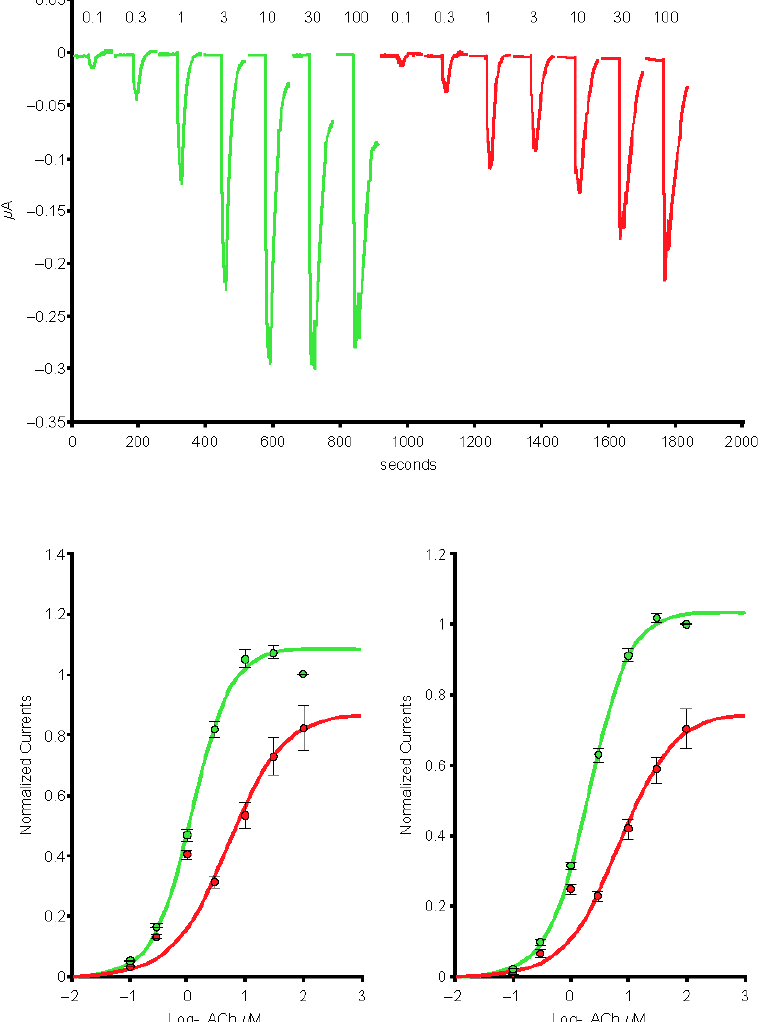
Figure 5. Effects of SARS-CoV-2 Spike protein S1 subunit at the human α 4 β 2 nicotinic acetylcholine receptor. Typical currents were recorded in the same cell before (green traces) and during exposure to 1 µ g/mL of the Spike protein S1 subunit (red traces). Currents were elicited by brief exposure to acetylcholine (ACh) test pulses with a series of concentrations. Currents were normalized to unity vs. the maximal value and average results obtained in six cells were plotted vs. the logarithm (log) of the ACh concentration. The green curve is the best fit obtained with the Hill equation. Areas under the curve are plotted on the lower right-hand side.